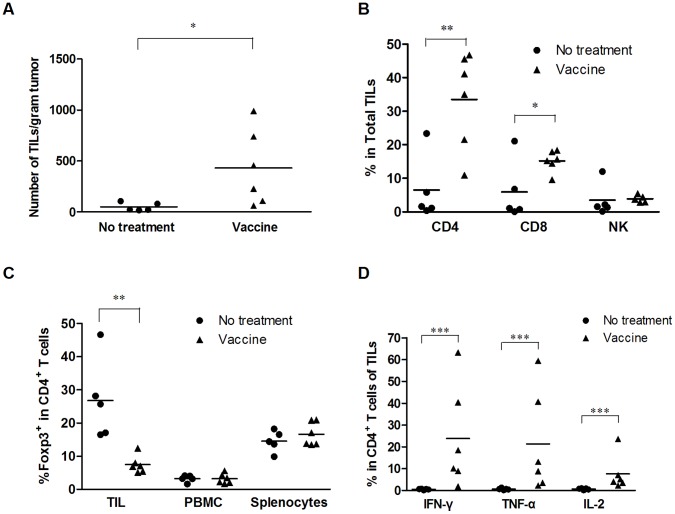
HCA587 protein vaccine enhances intratumoral accumulation of HCA587-responsive CD4+ T lymphocytes.C57BL/6 mice (5–6 per group) were inoculated with B16-HCA587 cells, and left untreated or treated with HCA587 protein vaccine on day 7 and 28 post inoculation. Two weeks after the last treatment, tumor tissues were collected and TILs were isolated. (A) Number of TILs. Data are presented as the cell number per gram of tumor mass. (B) Representation of major subsets of immune cells in TILs. TILs were analyzed by flow cytometry and the percentage of CD4+ T, CD8+ T and NK1.1+ cells were calculated. (C) Percentage of Foxp3+ cells in the CD4+ populations in the tumor, PBMCs, or spleen. (D) HCA587-responsive CD4+ T cells in TILs. TILs were plated at a density of 5×106 cells per well in 24-well dishes in RPMI1640 with 10% FBS and 10µg/ml HCA587 protein at 37°C and 5% CO2 for 24 hours, and 10 µg/ml brefeldin A was added 18 hours before harvesting the cells from the culture. Intracellular staining was then performed to detect the production of IFN-γ, TNF-α and IL-2. The percentages of cytokine-producing cells are presented among intratumoral CD4+ T cells. Each dot or triangle represents an individual sample, and horizontal bars denote the mean. *, P<0.05; **, P<0.01, ***, P<0.001, compared with untreated group.